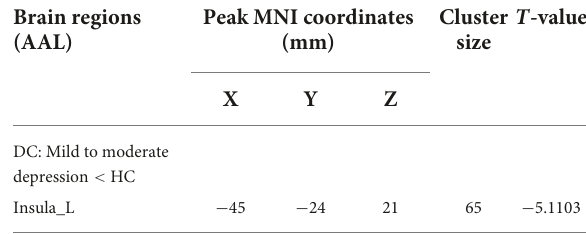
TABLE 3 Significant differences in DC between mild to moderate depression and healthy controls.